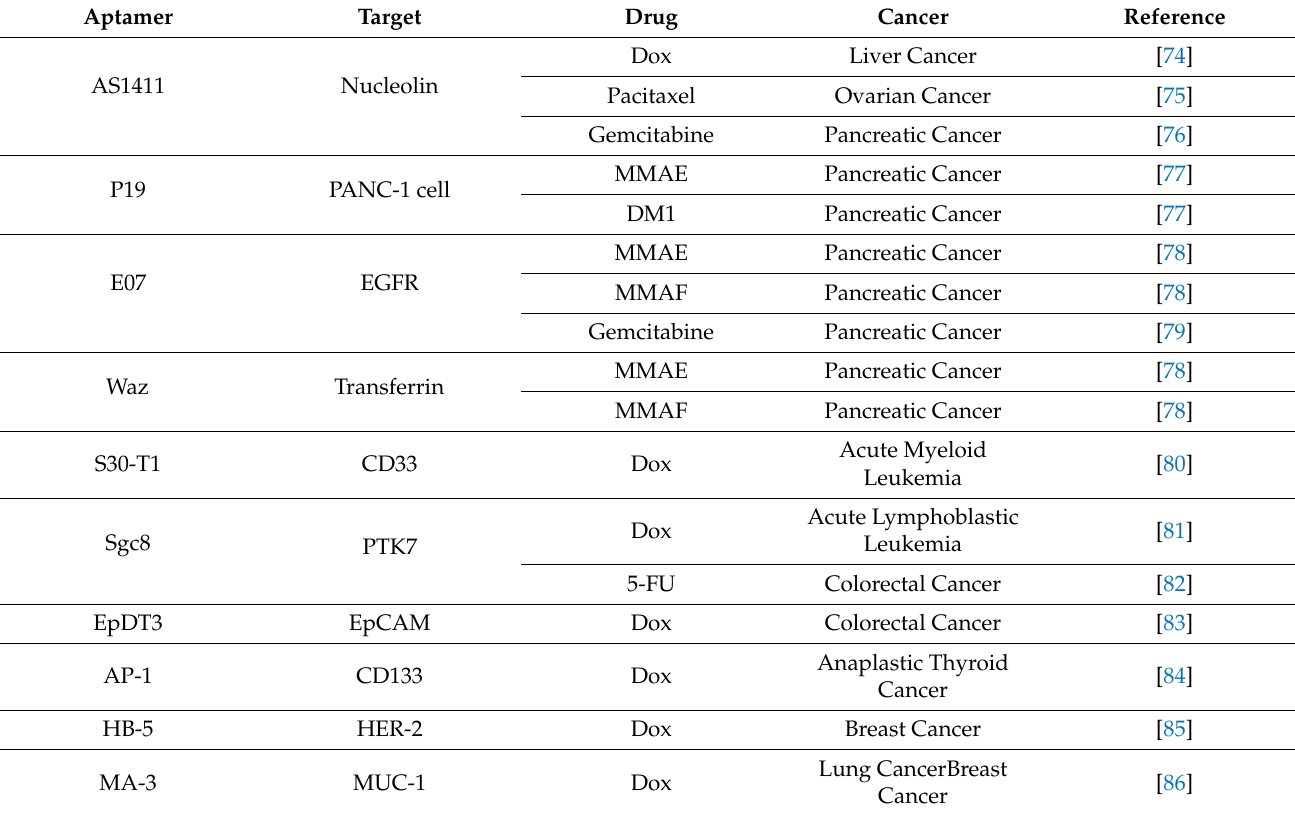
Table 2. Aptamer–drug conjugates for cancer